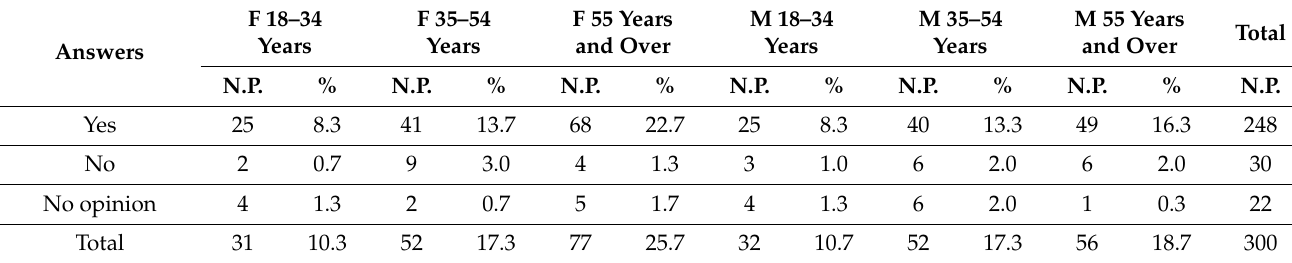
Table 6. Respondents’ answers (by sex and age) to the question: do you appreciate this area’s natural diversity? (Source: the authors).